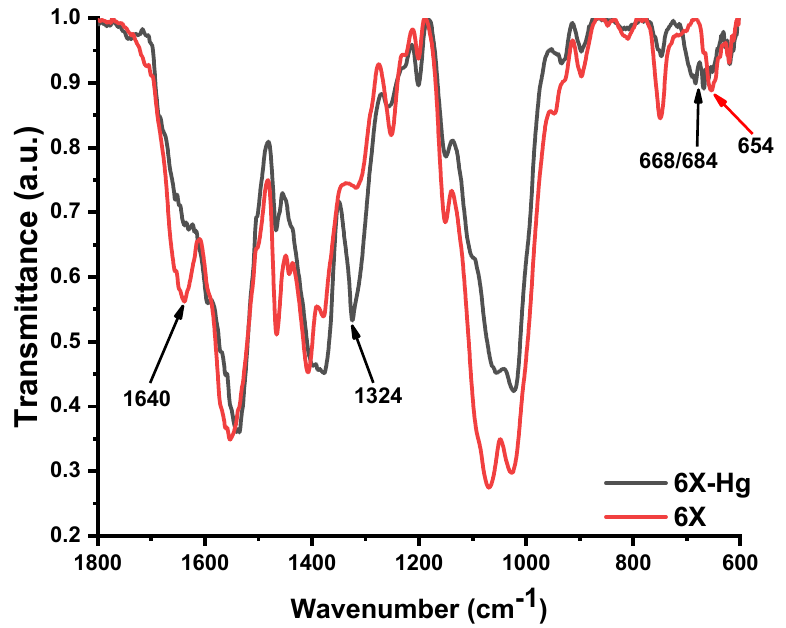
Figure 11. FTIR spectra of the xerogel 6X before (6X) and after mercury recovery (6X-Hg).